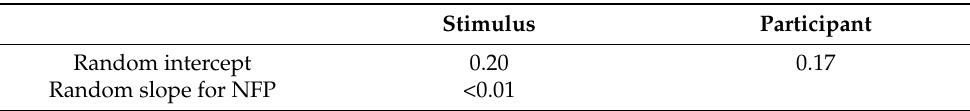
Table 7. ICC random effects in mixed-effects model a with random slope for NFP in the subset of participants exposed to products with Nutri-Score.